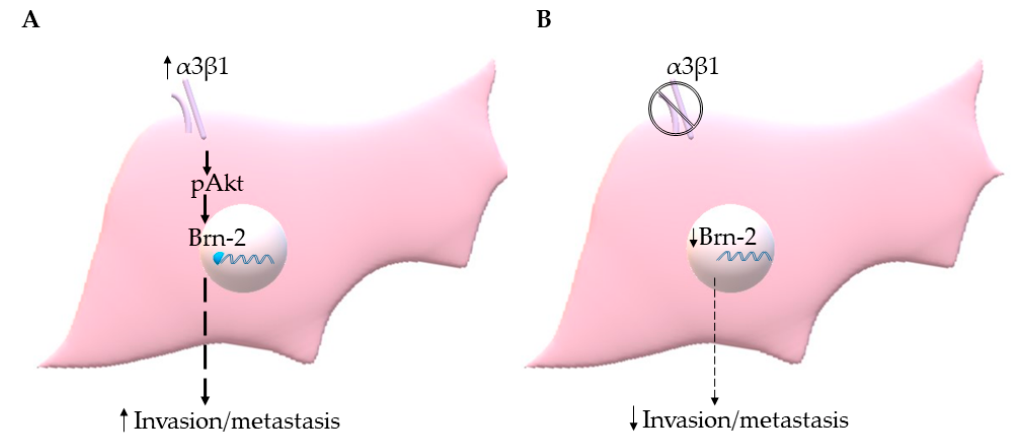
Figure 9. ( A ) Integrin α 3 β 1 signaling through Akt induces Brn-2 to stimulate invasion/metastasis of TNBC cells. ( B ) Suppression of α 3 β 1 leads to reduced Brn-2, which in turn results in the decreased invasive and metastatic potential of TNBC cells.